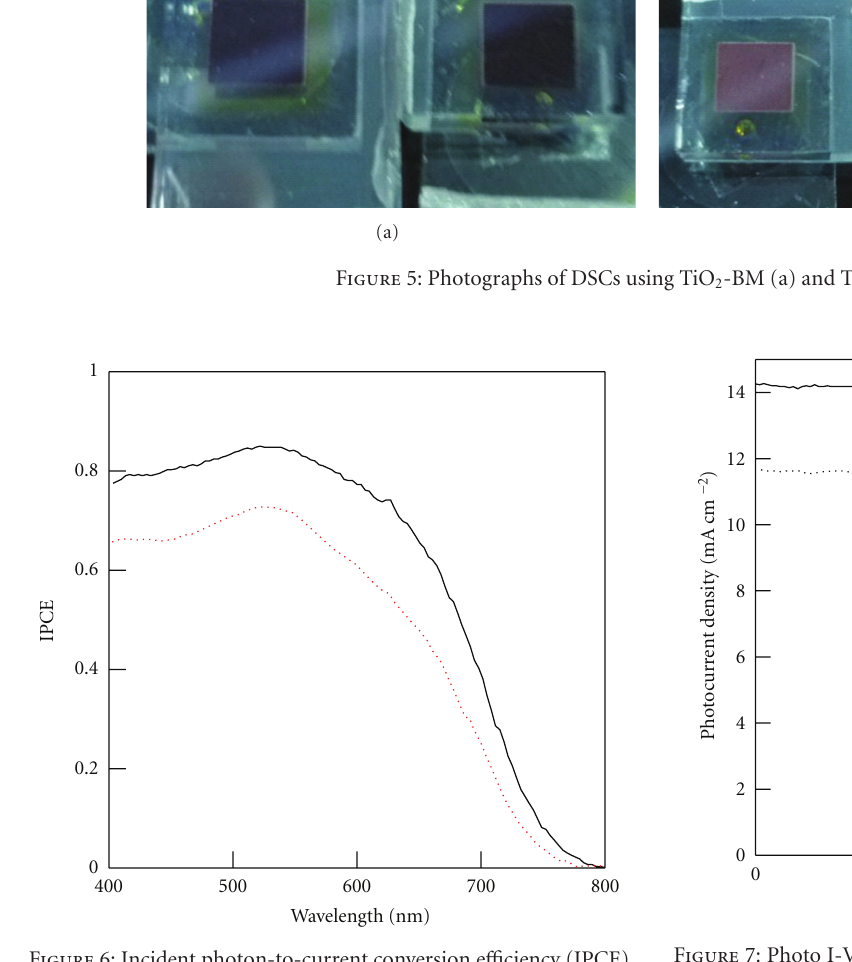
Figure 7: Photo I-V curve of DSCs under 100 mA cm − 2 (AM 1.5): TiO 2 -BM paste (solid line), TiO 2 -MG paste (dotted line). The active areas of DSCs were 5 × 5 mm 2 .